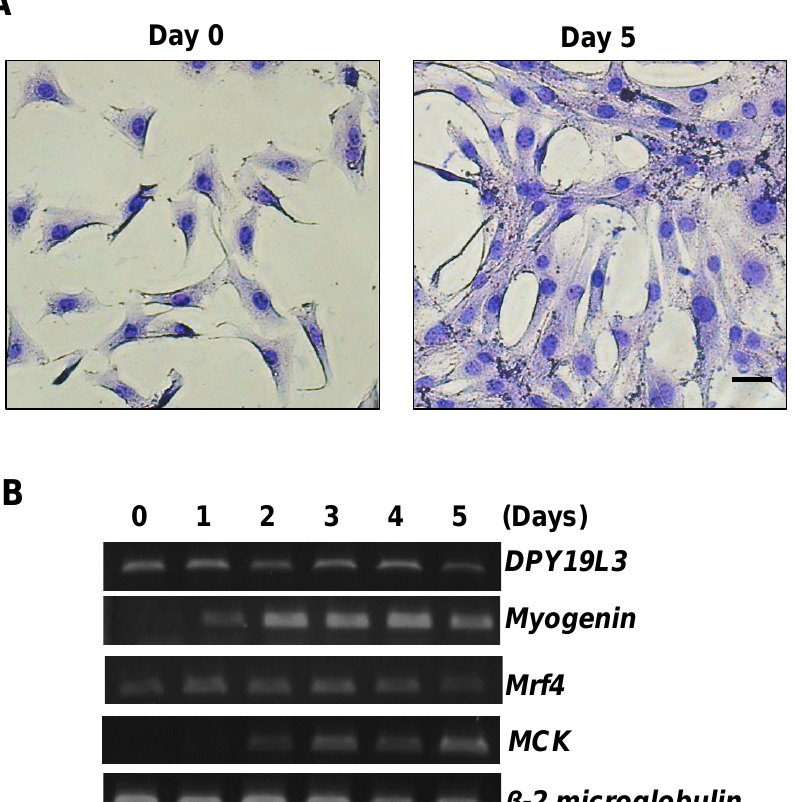
Figure 1. DPY19L3 is expressed during myogenic differentiation. ( A ) Representative image of the growing and differentiating cells. C2C12 cells were cultured in growing medium (GM), and the culture medium was changed from GM to differentiating medium (DM) for 0 (left) or 5 days (right). The cells were visualized with May–Grünwald Giemsa stain and photographed. Bar, 100 μm. ( B ) Increase of DPY19L3 gene expression during myogenic differentiation. Total RNAs were isolated from C2C12 cells every day after changing the medium to DM, and RT-PCR was performed. Myogenin , mrf4 , and MCK were monitored as differentiation